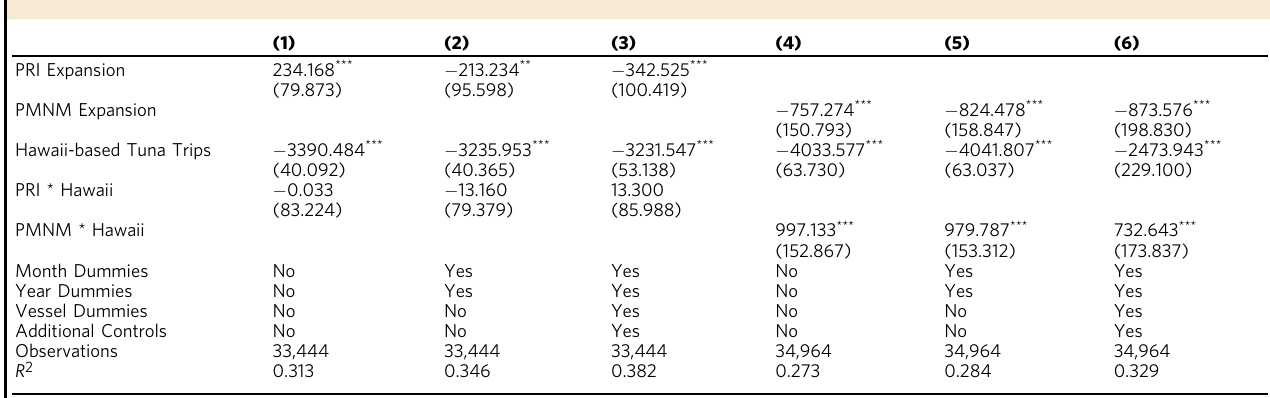
Table 1 Difference-in-differences